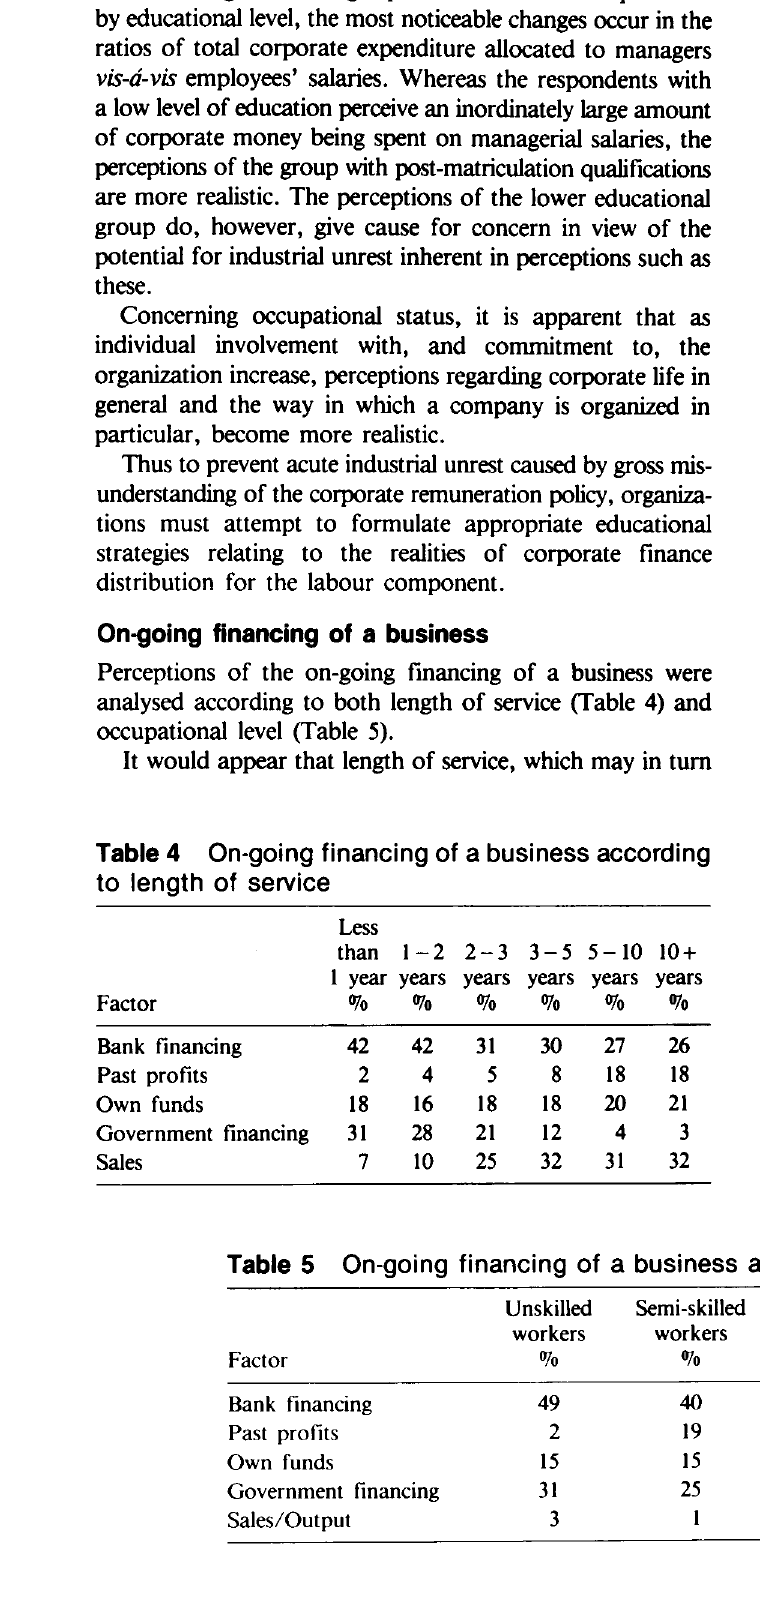
Formulae for achieving improved productivity according to